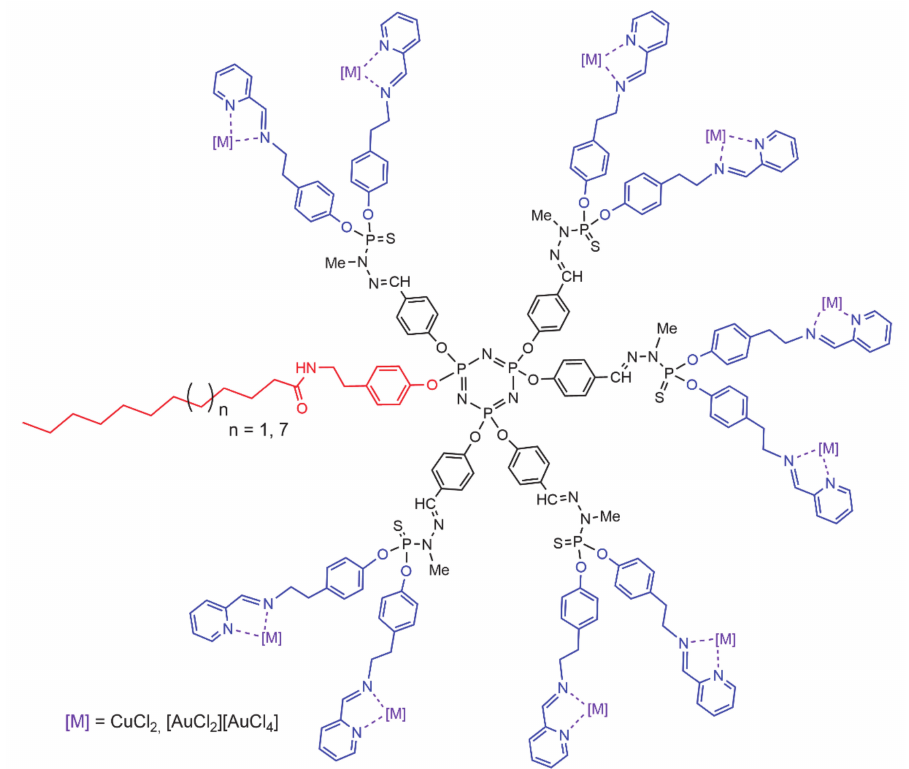
Figure 13. Dendrons having an alkyl chain at the core, and pyridine-imine functions complexing copper or gold on the